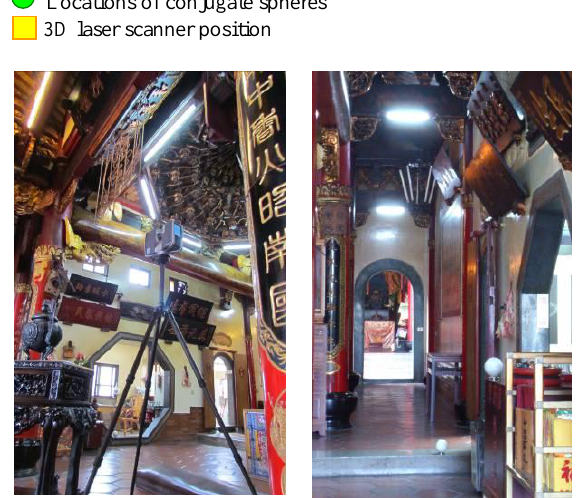
Figure 8. Location of scanner position 1, and locations of conjugate sphere a and conjugate sphere